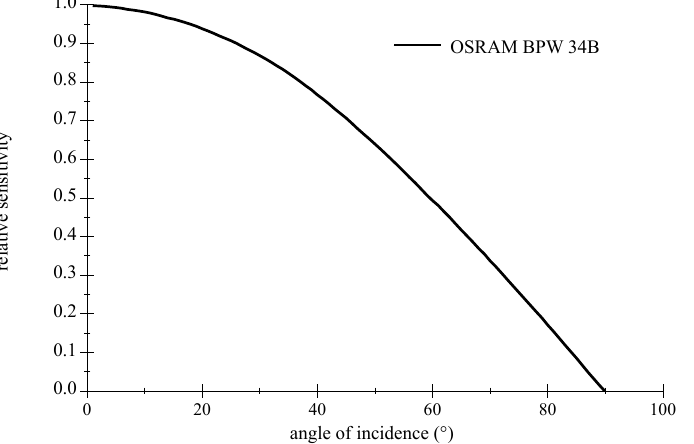
Figure 6. Directional characteristics of an OSRAM BPW 34B Si PIN Photodetector. Redrawn with values from datasheet